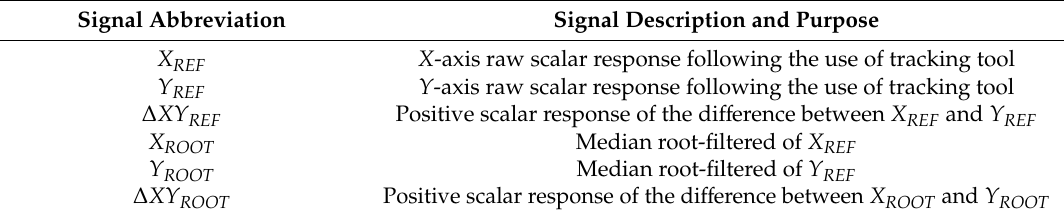
Table 1. Signals extracted and processed and their purpose in this study.